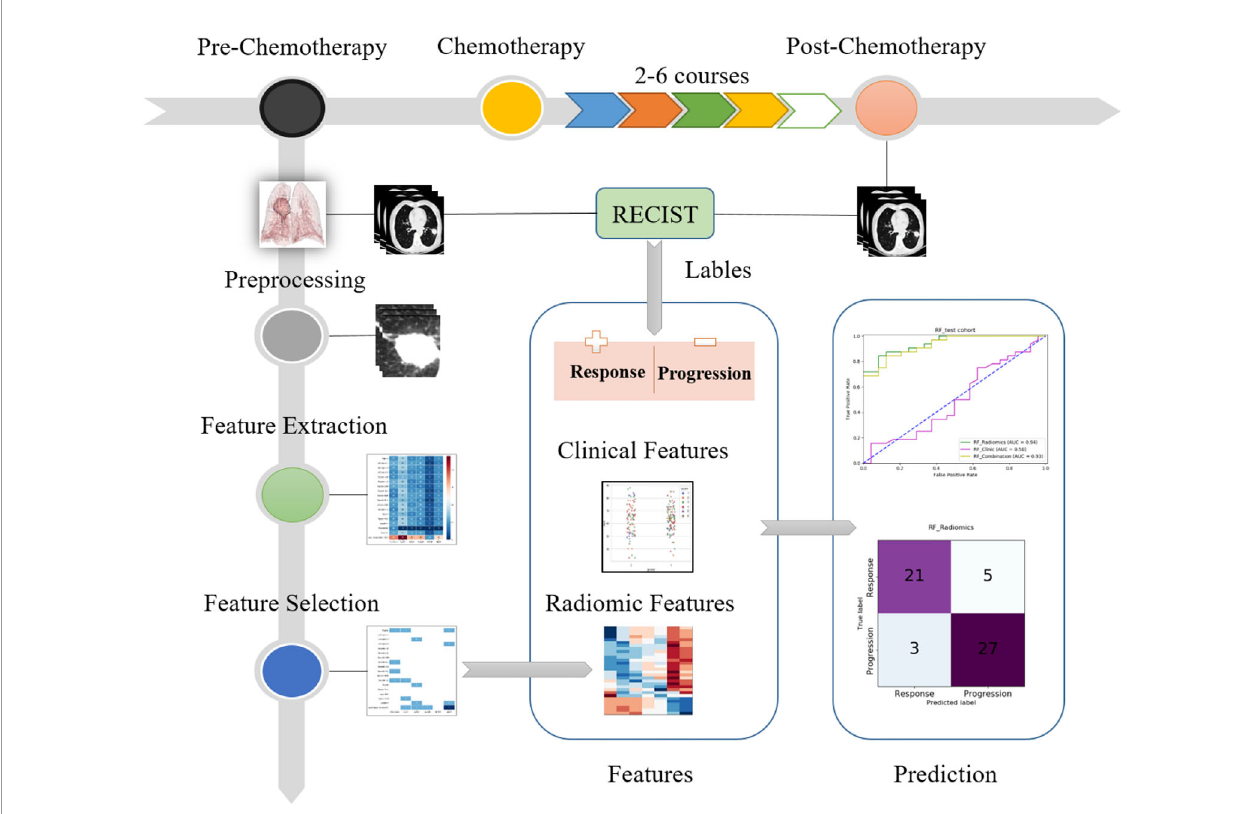
FIGURE 2 | Flowchart of present